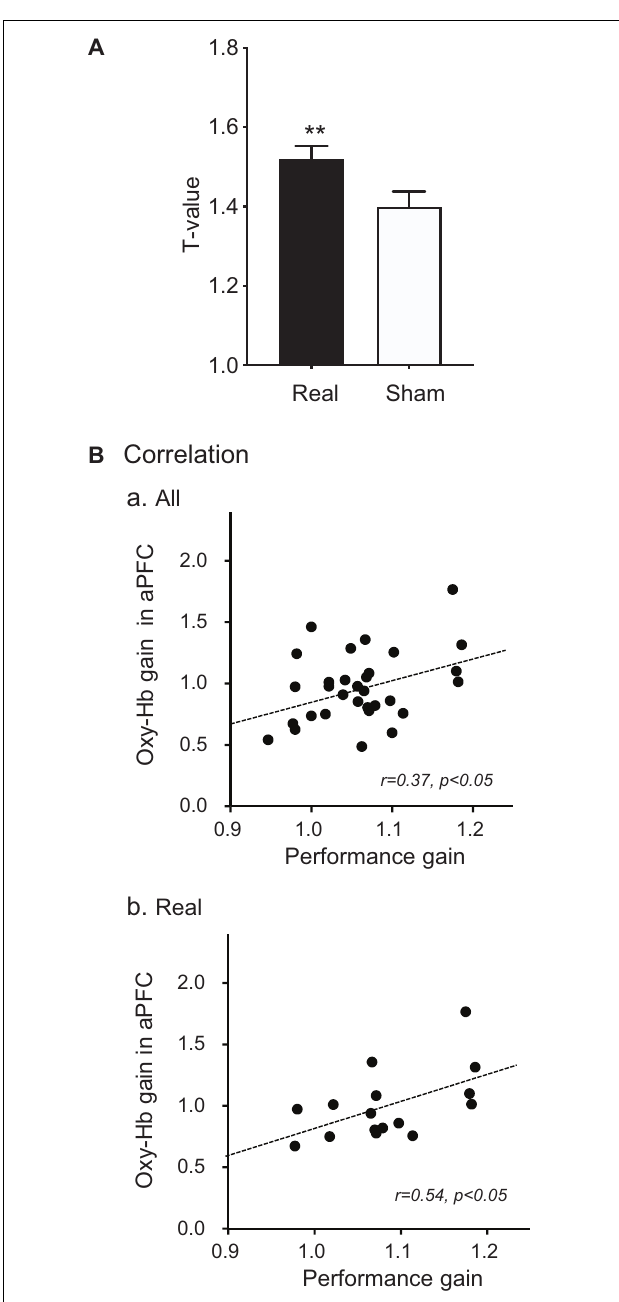
FIGURE 5 | Effects of motor imagery training on aPFC activity (A) and performance gain (B) . (A) Comparison of cortical activation (mean t -values) in the aPFC during the motor imagery task between the real and sham groups. ** P < 0.01. (B) Correlation between Oxy-Hb gain in the aPFC in motor imagery training and hand performance gain in the Purdue Pegboard test in all subjects (a) and in the real group (b) .